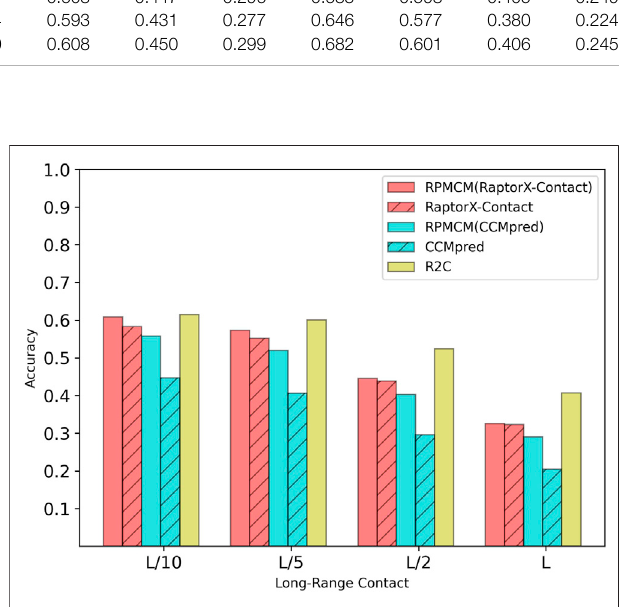
FIGURE 5| Comparison of method accuracy for the long-range contact on the CASP11 testing dataset.